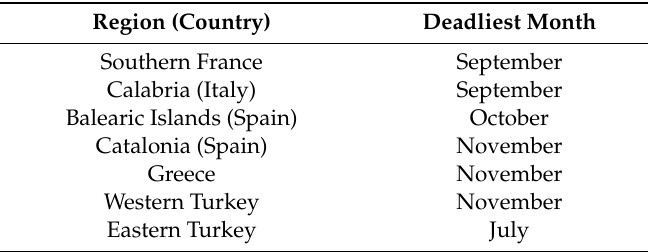
Table 3. Deadliest month per